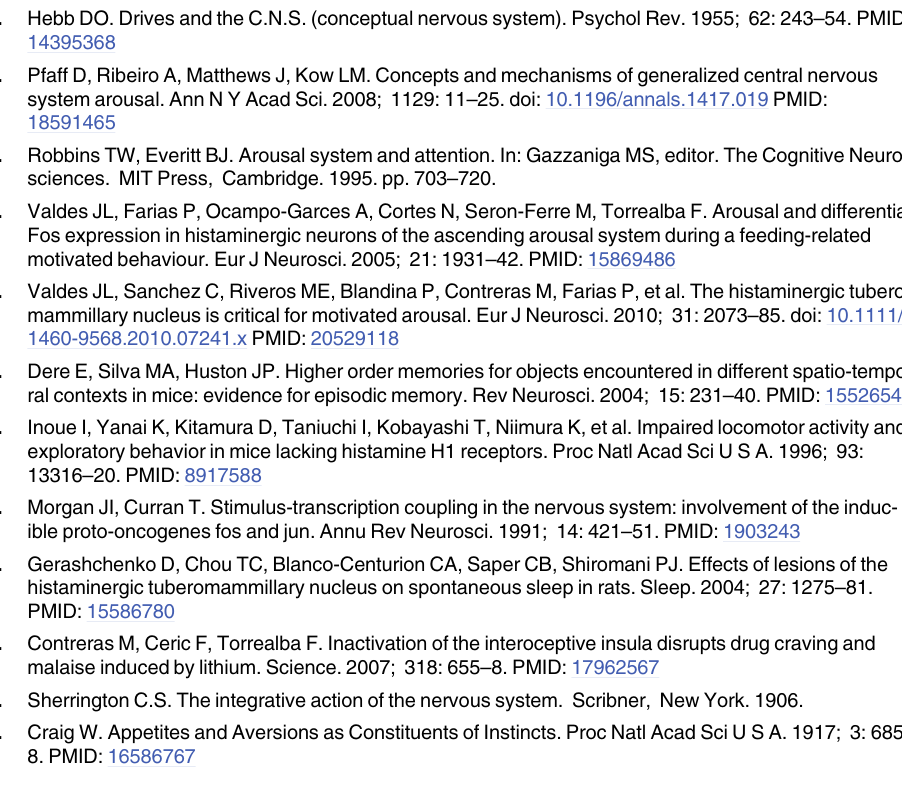
S1 Fig. Appetitive behaviors did not change Fos-ir expression in the